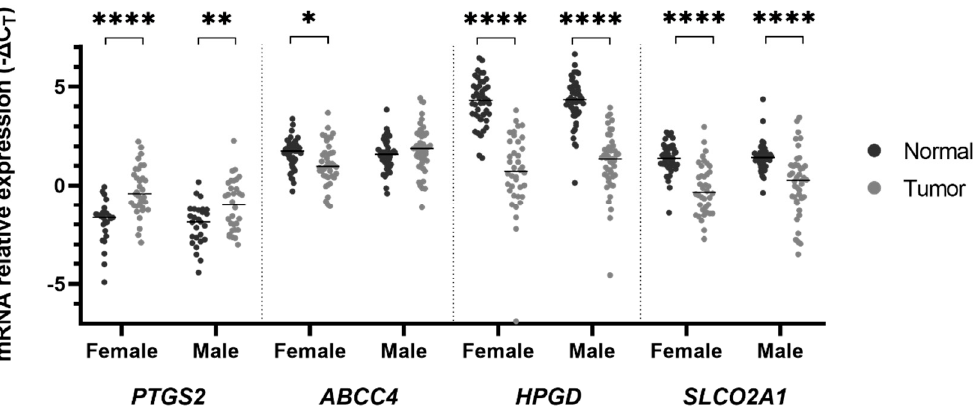
Figure 3. mRNA expression according to gender. PTGS2 is upregulated in tumor samples by a mean factor of 2.64 in females and 2.05 in males, whereas HPGD and SLCO2A1 genes are downregulated compared to “normal”-appearing mucosa samples by a mean factor of 0.08 and 0.34 (females) and 0.12 and 0.41 (males), respectively. The ABCC4 gene is also downregulated by a mean factor of 0.71 in tumoral samples in females. Lines represent median values of expression. * p < 0.05; ** p < 0.01; **** p < 0.0001.